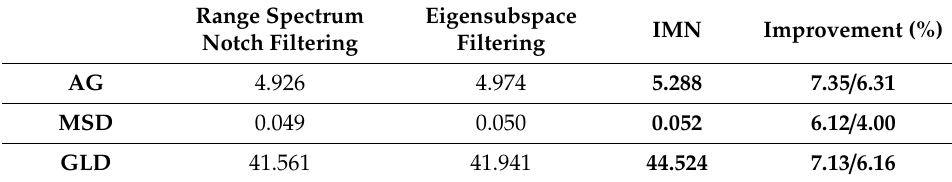
Figure 13. Mitigation results. ( a ) the SAR image without interference mitigation, ( b ) the SAR image after applying the range-spectrum notch filtering, ( c ) the SAR image after applying the eigensubspace filtering, and ( d ) the SAR image after applying the IMN. Table 5. The SAR image quality evaluation for the measured NBI-contaminated data.